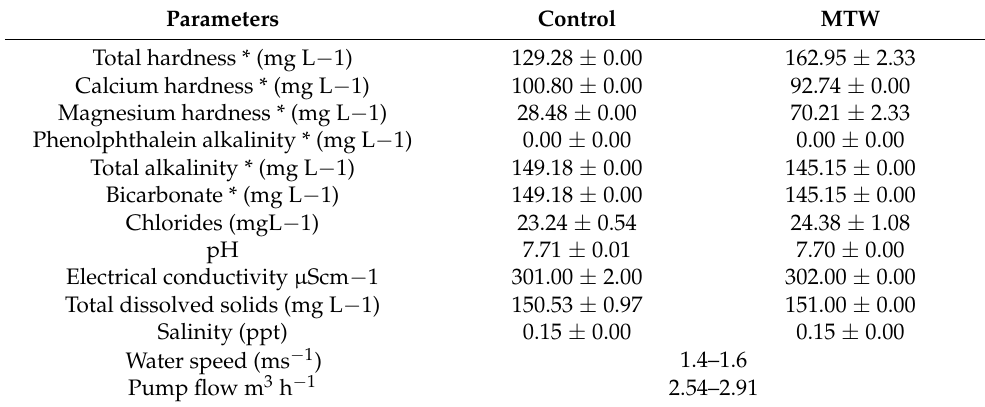
Table 3. Physico-chemical analysis of irrigation water at CNEA’s experimental plot farm for the cultivation of Phaseolus vulgaris L. *: expressed as CaCO 3